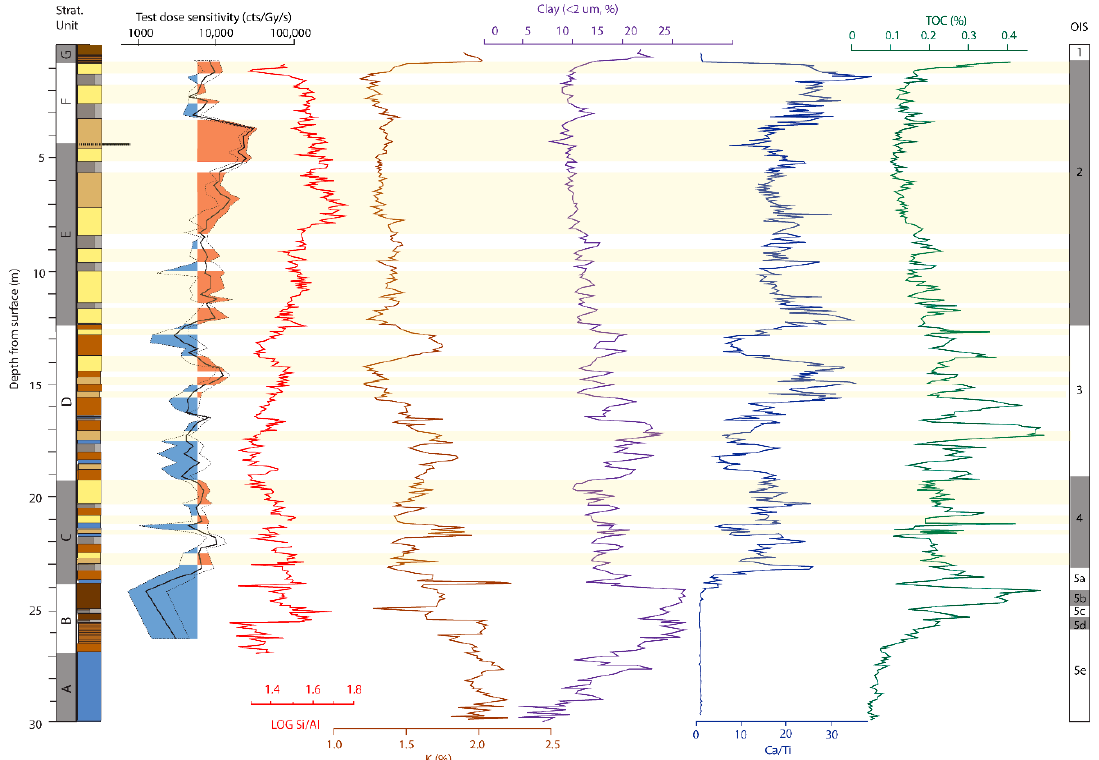
Figure 6. Comparison of bulk IR 50 luminescence sensitivity (black solid line representing mean sensitivity, and dotted line representing 1 σ range) with Si/Al ratio (red), potassium concentration (brown), percentage clay (defined as <2 µm; purple), Ca/Ti ratio (dark blue) and total organic carbon (TOC; green), for the REM3 LPS. Primary and reworked loess unit depths are highlighted in yellow. Where IR 50 sensitivities exceed 5 750 cts/Gy and correspond to primary or reworked loess sediments, these are shaded in red-brown; reduced sensitivities below the same threshold which correlate to palaeosols or fluvial sediments are shaded in blue. Stratigraphy and correlation to oxygen isotope stages [53] are shown for comparison; stratigraphic legend can be found in Figure 4.